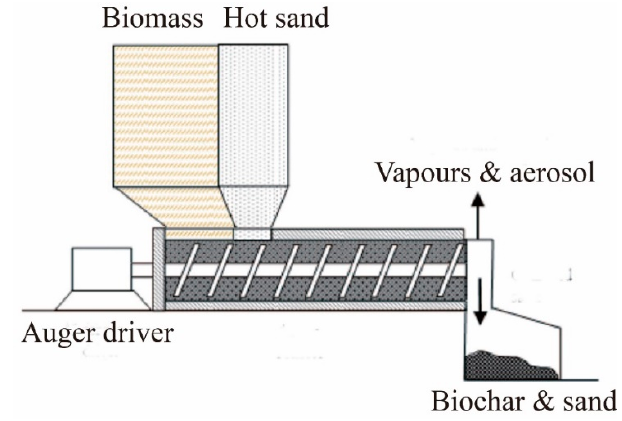
Figure 9. Schematic for the Auger reactor.